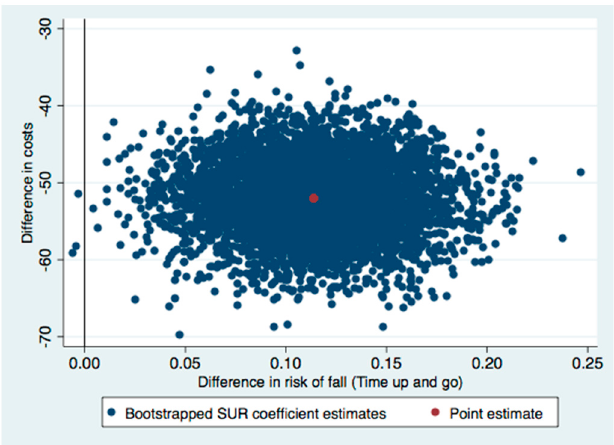
Figure 3. Cost-effectiveness plane for risk of fall using the timed up and go instrument. SUR: seemingly unrelated regression.